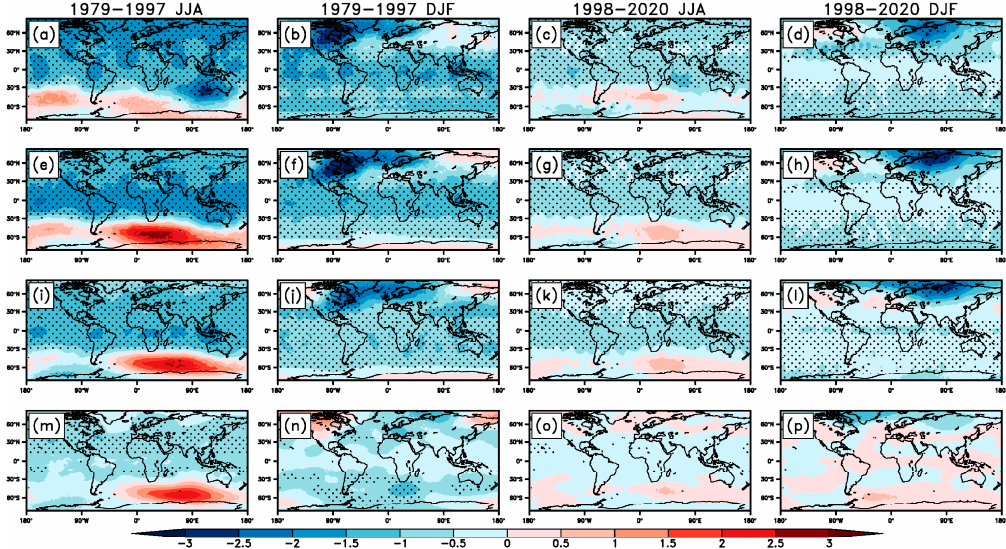
Figure 4. Geographic distributions of linear trends of stratospheric temperature over (left two columns) 1979–1997 and (right two columns) 1998–2020 in JJA and DJF in SSU channel ( a – d ) 3 (~40–50 km), ( e – h ) 2 (~35–45 km), ( i – l ) 1 (~25–35 km), and ( m – p ) TLS. Regions with dots are the places where trends have statistical significance levels higher than the 95% confidence level.